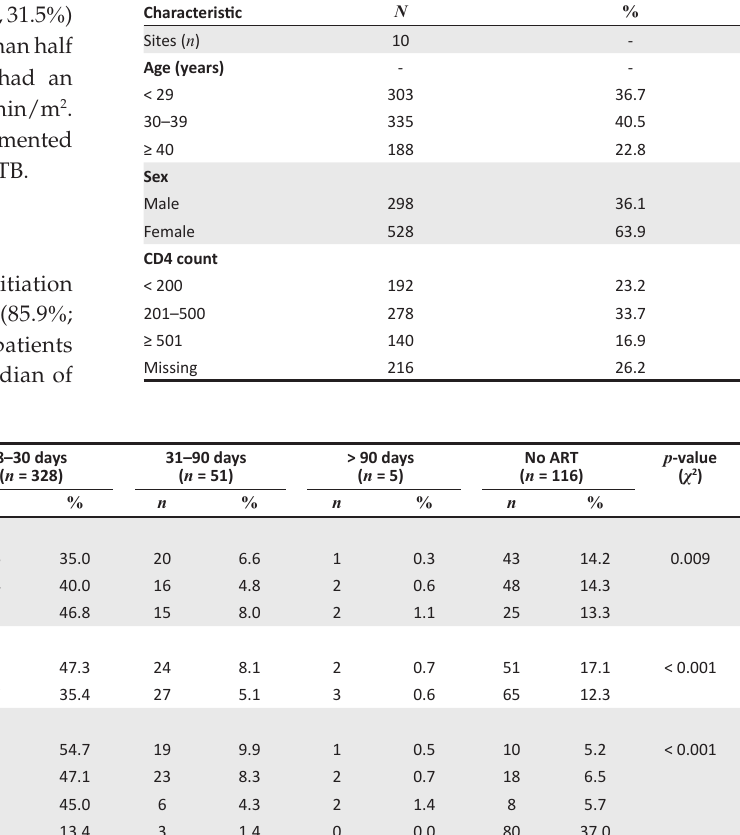
TABLE 1: Study population characteristics for 826 patients.